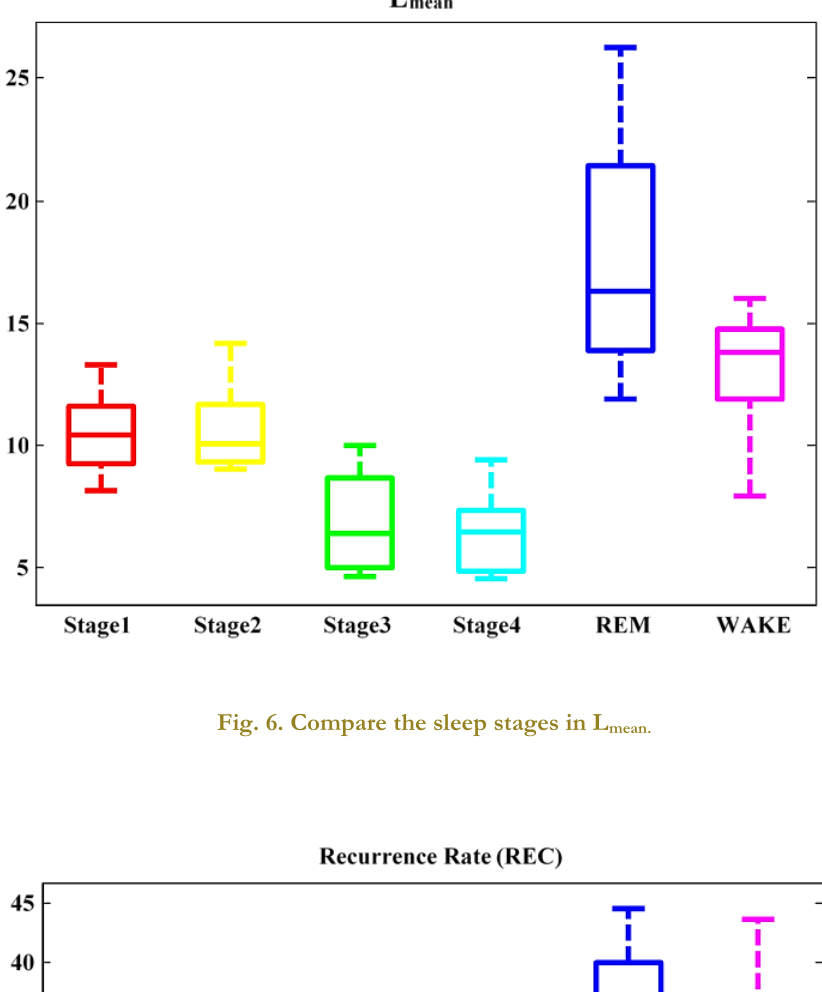
Fig. 6. Compare the sleep stages in L mean.